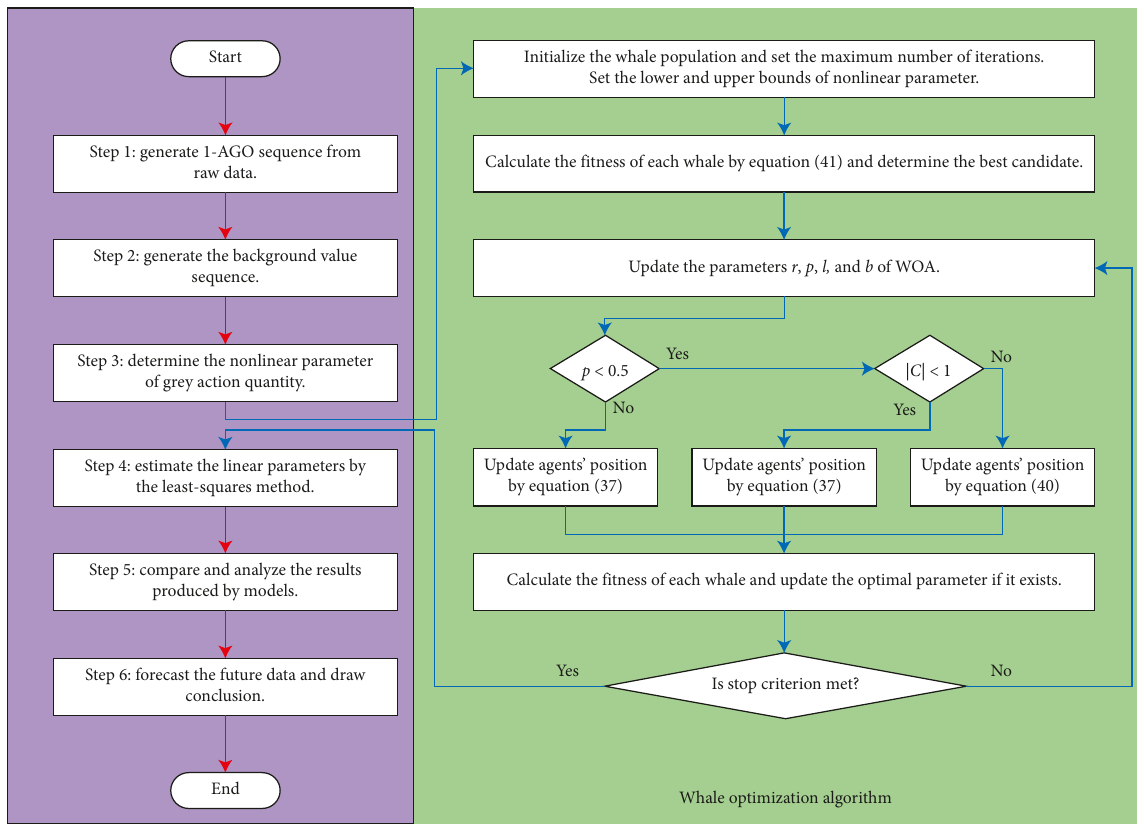
Figure 1: The flowchart of the power-driven grey